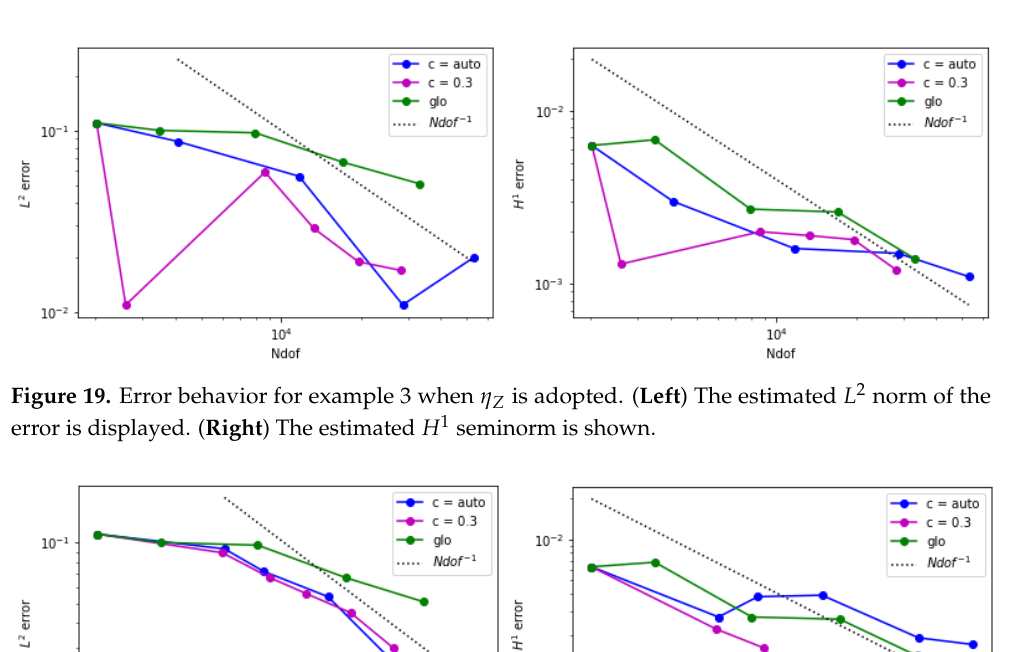
Figure 18. Error behavior for example 3 when η R is adopted. ( Left ) The estimated L 2 norm of the error is displayed. ( Right ) The estimated H 1 seminorm is shown.